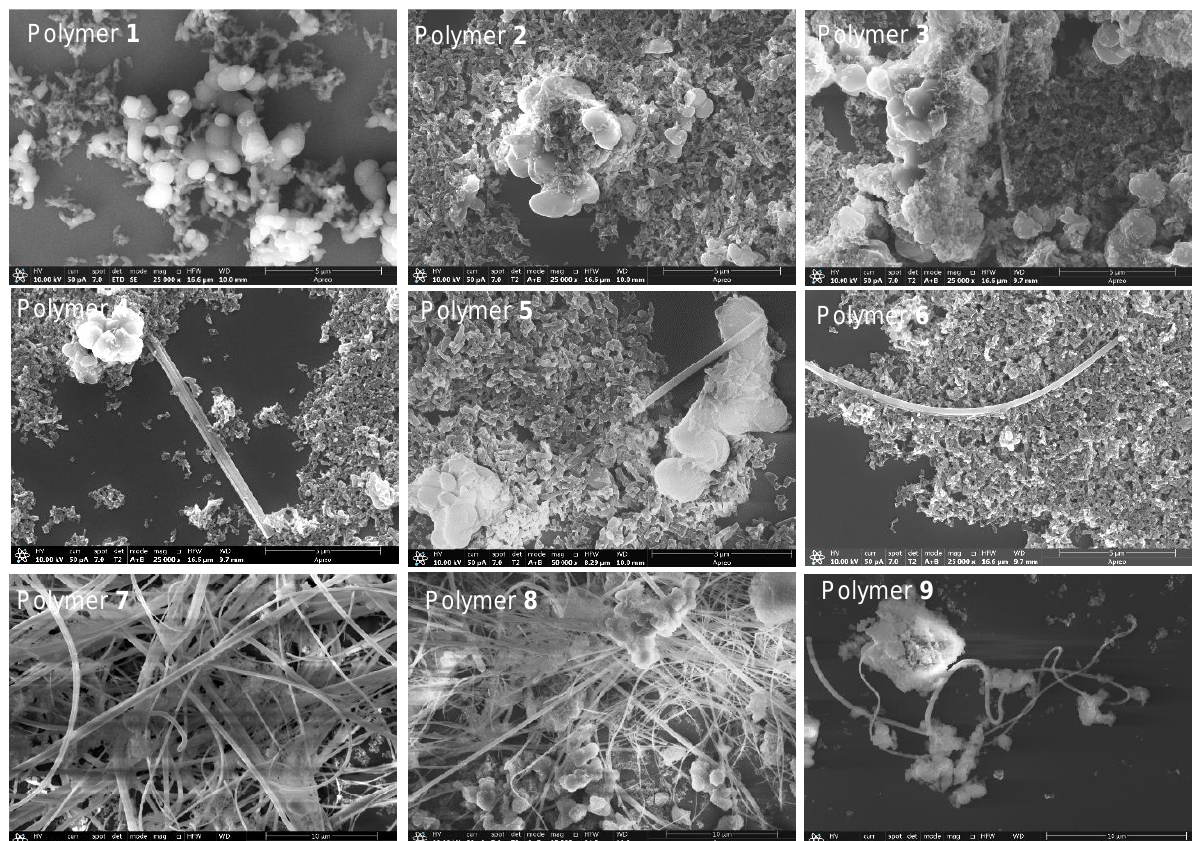
Figure 7. SEM images for NH 4 CN polymers representative samples from series 1 and 2, Table 1.